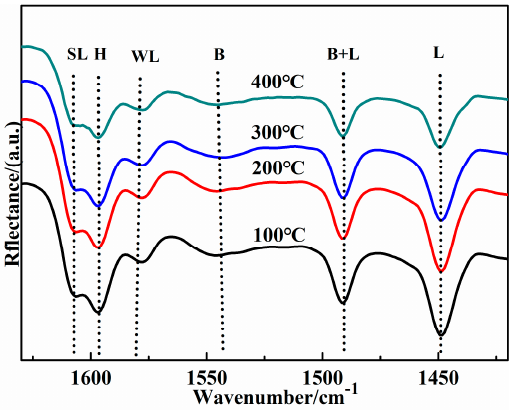
Figure 7. Py-IR spectra of 10 wt% NiP/H β calcined at different temperatures.